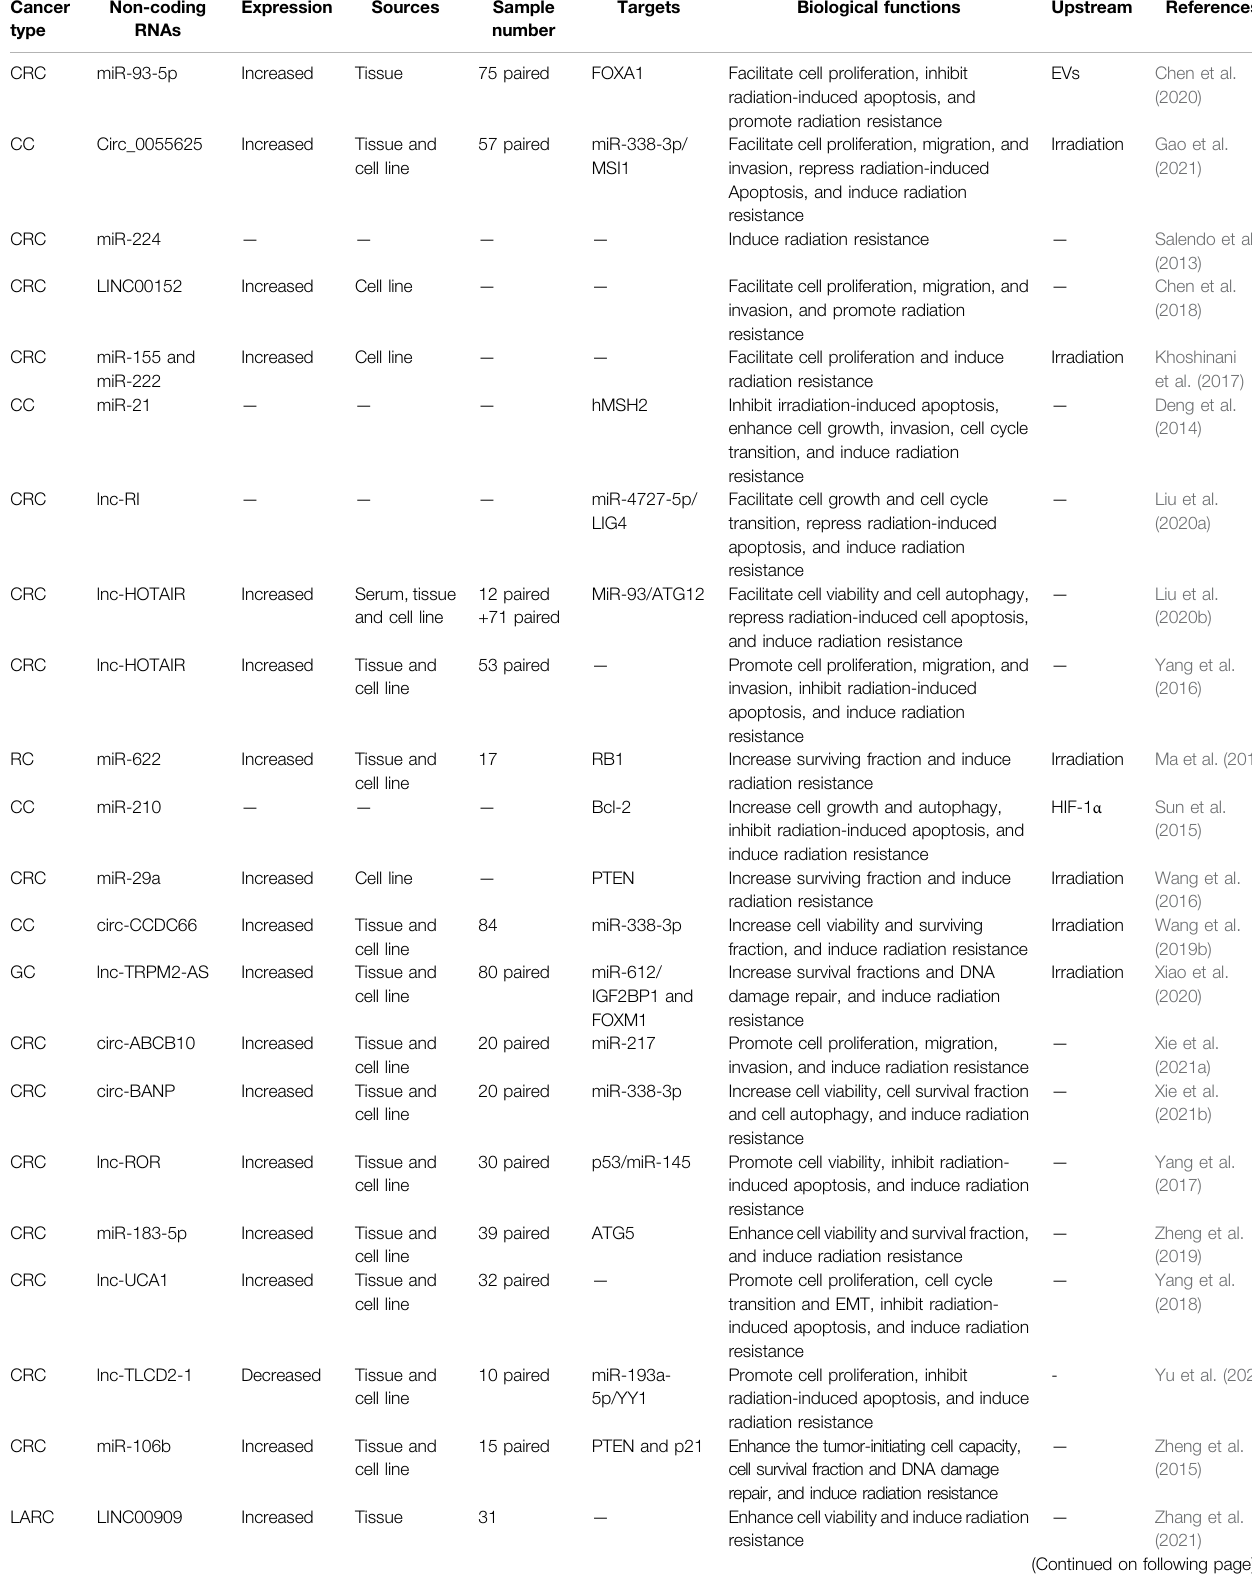
TABLE 2 | The radioresistance induction of non-coding RNAs in gastrointestinal